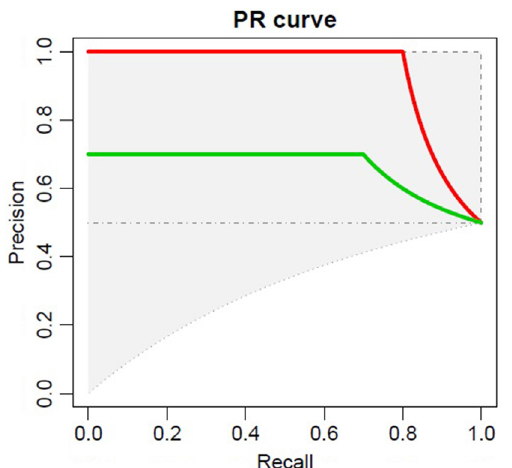
Fig. 10. The PR curves after applying the gene selection method for sample size of 10.